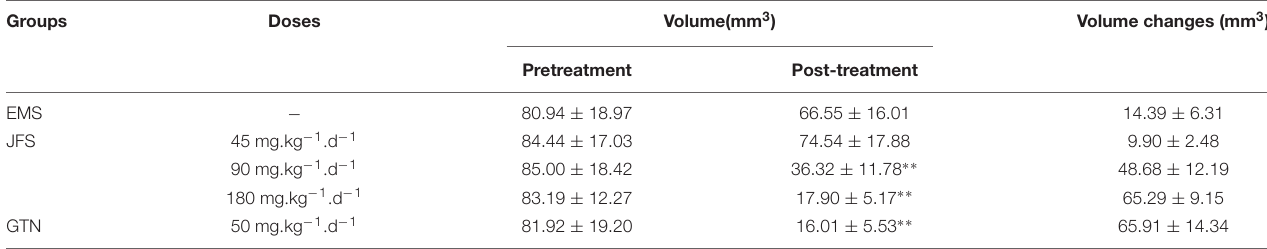
TABLE 3 | Effect of JFS on ectopic endometrium volume ( n = 6).